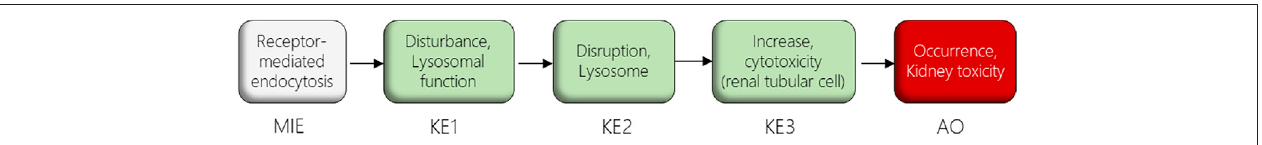
FIGURE1| AOPreceptor-mediatedendocytosisandlysosomaloverload.TheAOPdescribesthesequenceofkeyeventsleadingtokidneyinjuryasanAOinitiated by receptor-mediated endocytosis (MIE), subsequent disturbance of lysosomal function (KE1), disruption of lysosomes (KE2) and proximal tubule cell toxicity